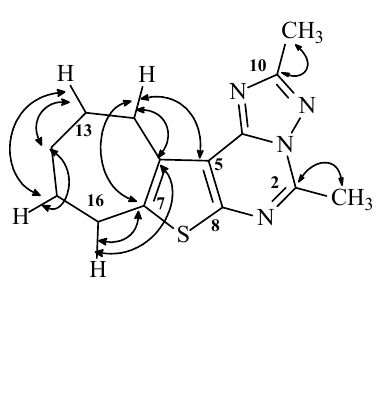
Figure 3. Selected HMBC spectrum of 43 .